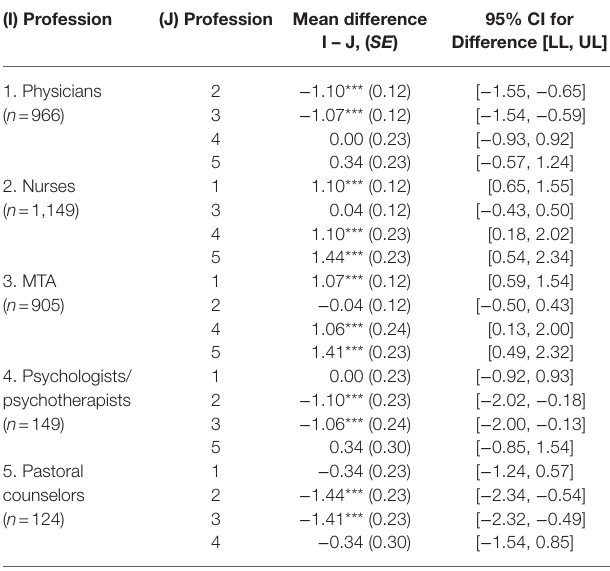
interval, and UL, upper limit of a confidence interval. MTA, medical-technical assistant.